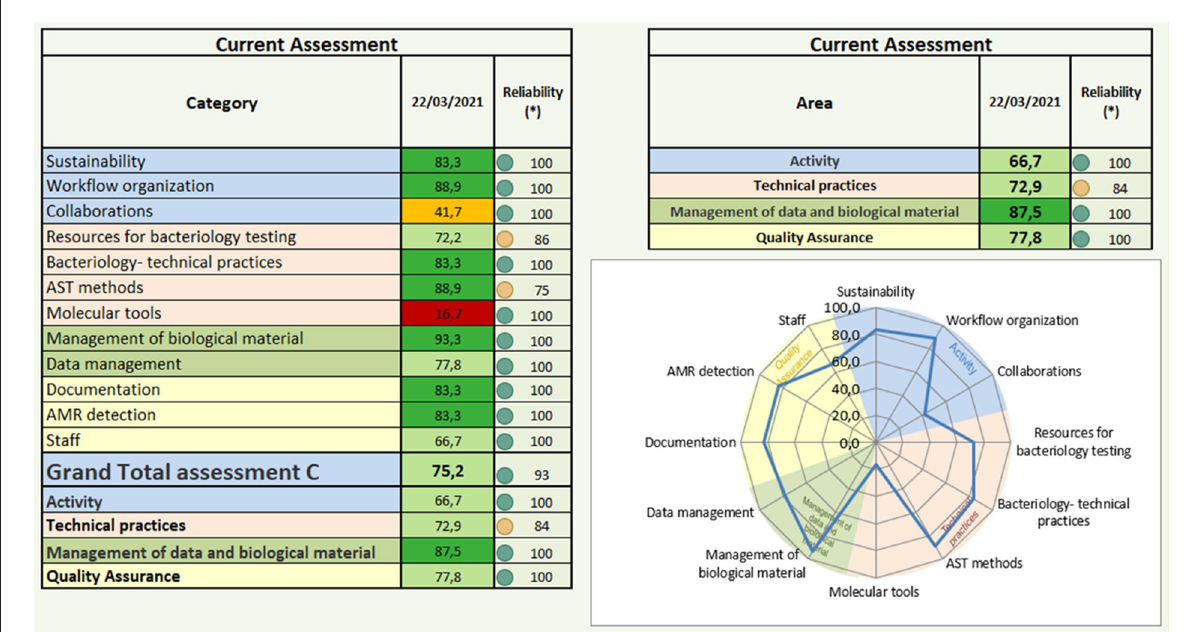
FIGURE1 Graphical representation of the laboratory assessment results using the Laboratory Mapping Tool for Antimicrobial Resistance (LMT-AMR). The scoring in this table is based on the ideal situation, with 100% being the score for an ideal laboratory. The number in each cell is the percentage achieved by the laboratory assessed, compared to the ideal. Numbers displayed in percentage; numbers in each cell represent the achieved percentage compared to the optimum (100% being the ideal laboratory). Color coding: 0–20% (dark red), 20–40% (light red), 40–60% (orange), 60–80% (light green, red), 80–100% (dark green). ( * ) Reliability of the result depends on the percentage of questions filled or left blank per category in the LMT questionnaire. From 100 to 90%, the LMT scoring is reliable (green dot). From 90 to 70%, reliability of the scoring is medium (orange dot), from 70 to 0%, reliability is low (red dot).